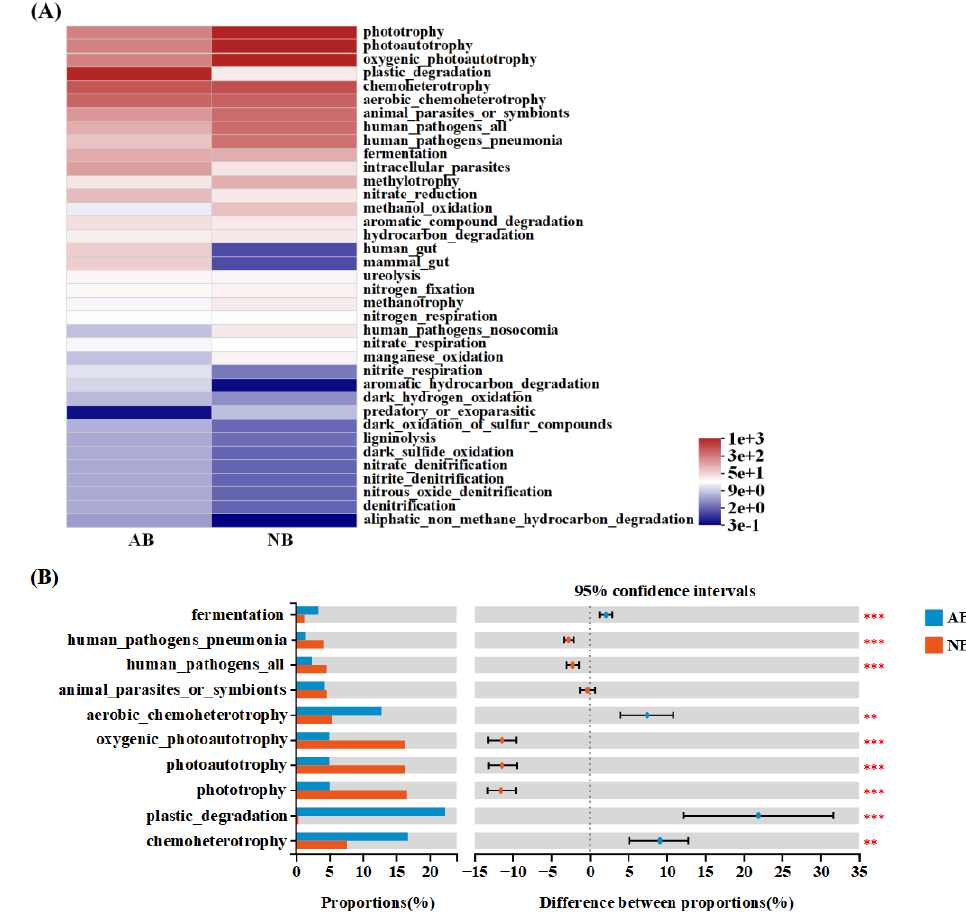
Figure 7. Functional distribution of B. calyciflorus -associated bacterial and bacterioplankton commu- nities based on FAPROTAX function prediction. ( A ) FAPROTAX function consequential heatmap; ( B ) FAPROTAX functional groups difference test. Showing the significant difference in functional groups of abundance in the top 10. The left shows the abundance ratio of different functional groups; the middle shows the percentage of functional group abundance differences within a 95% confidence interval. The right, ** p < 0.01 and *** p < 0.001.